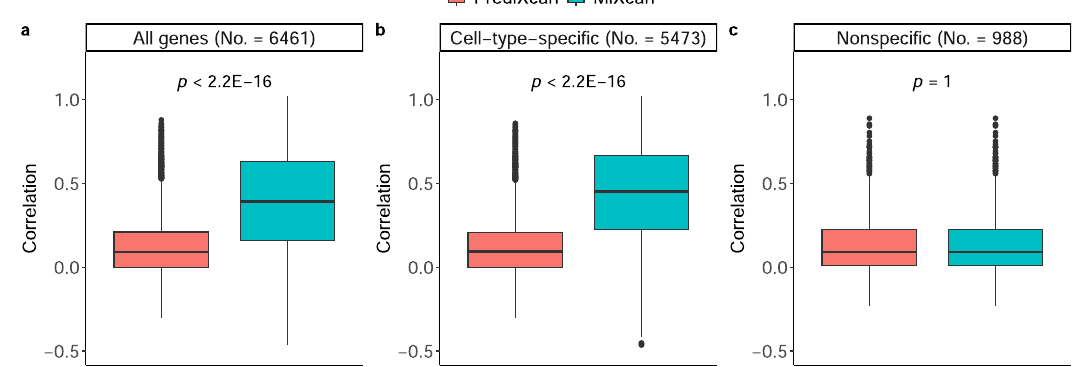
Fig. 2 | Validation of tissue-level GReX predictions in an independent bulk mammary tissue dataset. The correlation of tissue-level GReX predictions using MiXcan or PrediXcan with measured gene expression levels in adjacent normal mammarytissuesamplesfrom103Europeanancestrywomenwithbreastcancerin TCGA were computed for ( a ) all 6461 genes with MiXcan and PrediXcan models trained using mammary tissue samples from 125 European ancestry women in